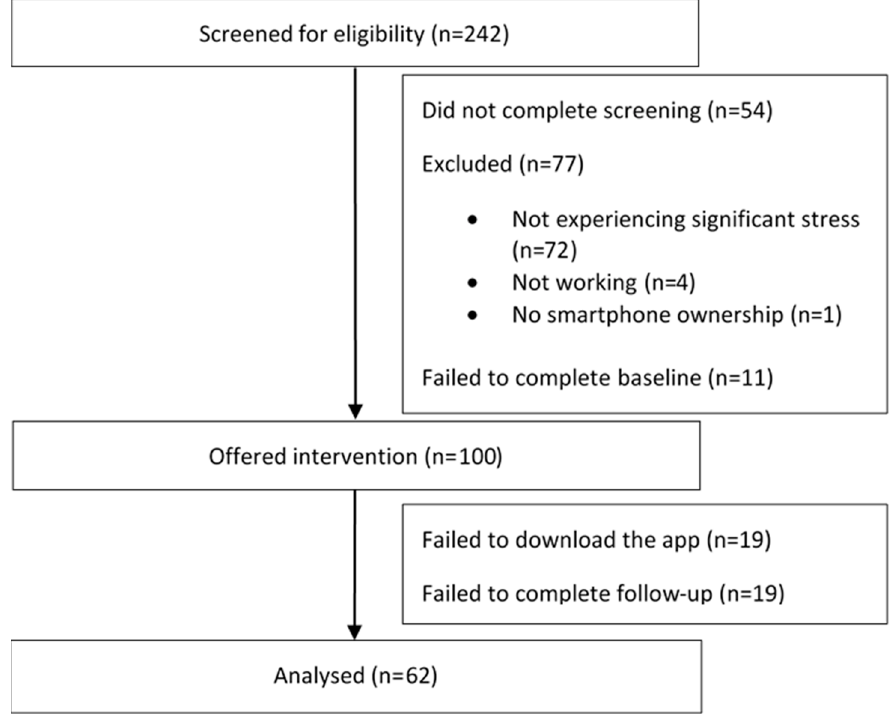
Figure 2. Flow of participants through the study.